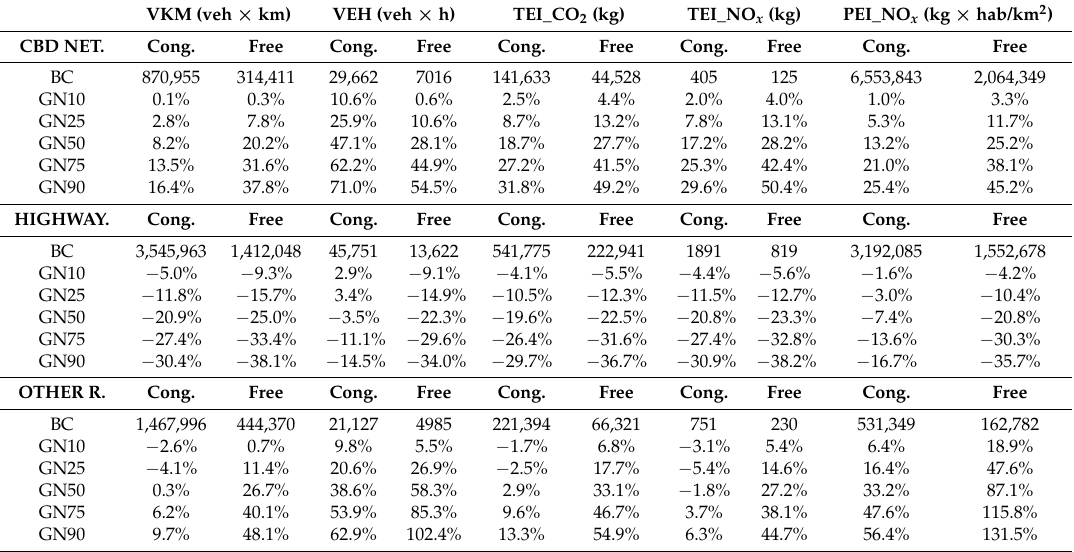
Table 4. Variation of traffic and environmental indicators by road type for each GN penetration rate. VKM (veh × km) VEH (veh × h) TEI_CO 2 (kg) TEI_NO x (kg) PEI_NO x (kg × hab/km 2 ) CBD NET. Cong. Free Cong. Free Cong. Free Cong. Free Cong.